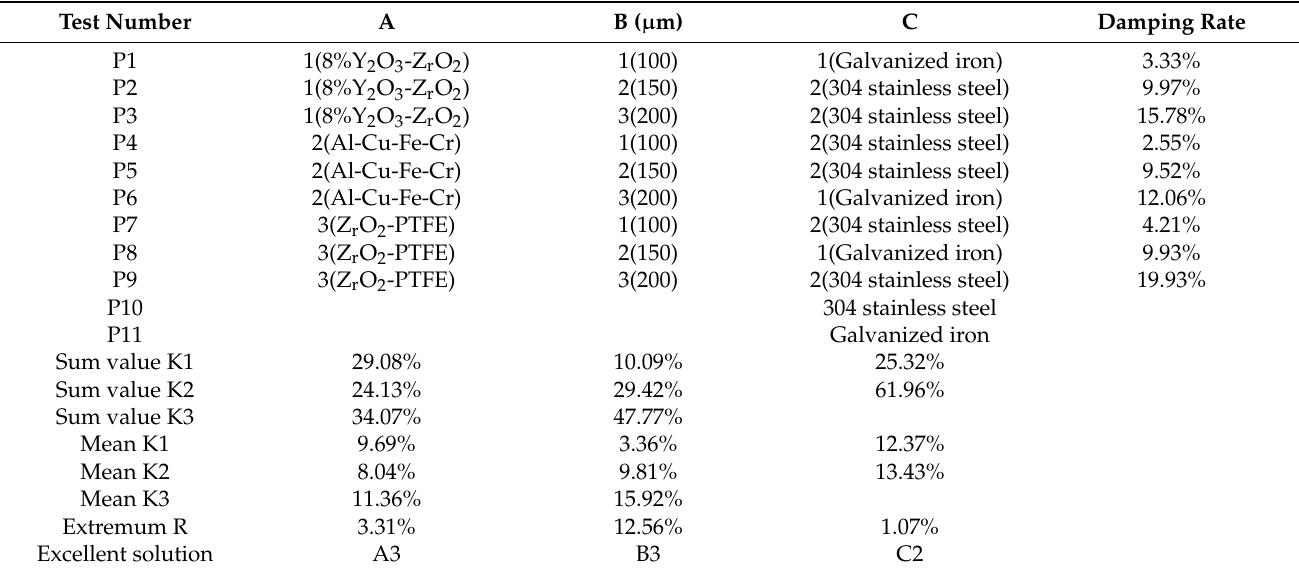
Table 13. Frequency sweep excitation vibration response orthogonal test conclusion table.